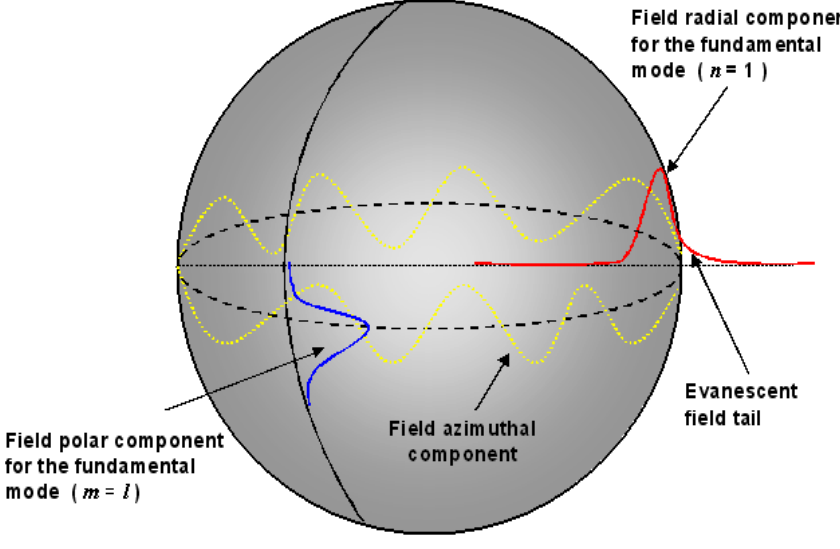
Figure 2. Spherical mode fields for the fundamental (n = 1)